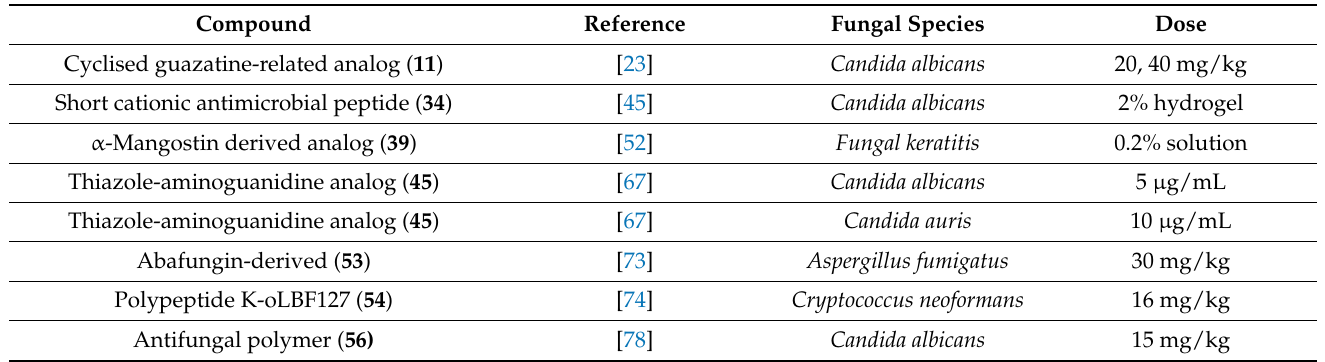
Table 1. Summary of the in vivo efficacy of guanidine-containing